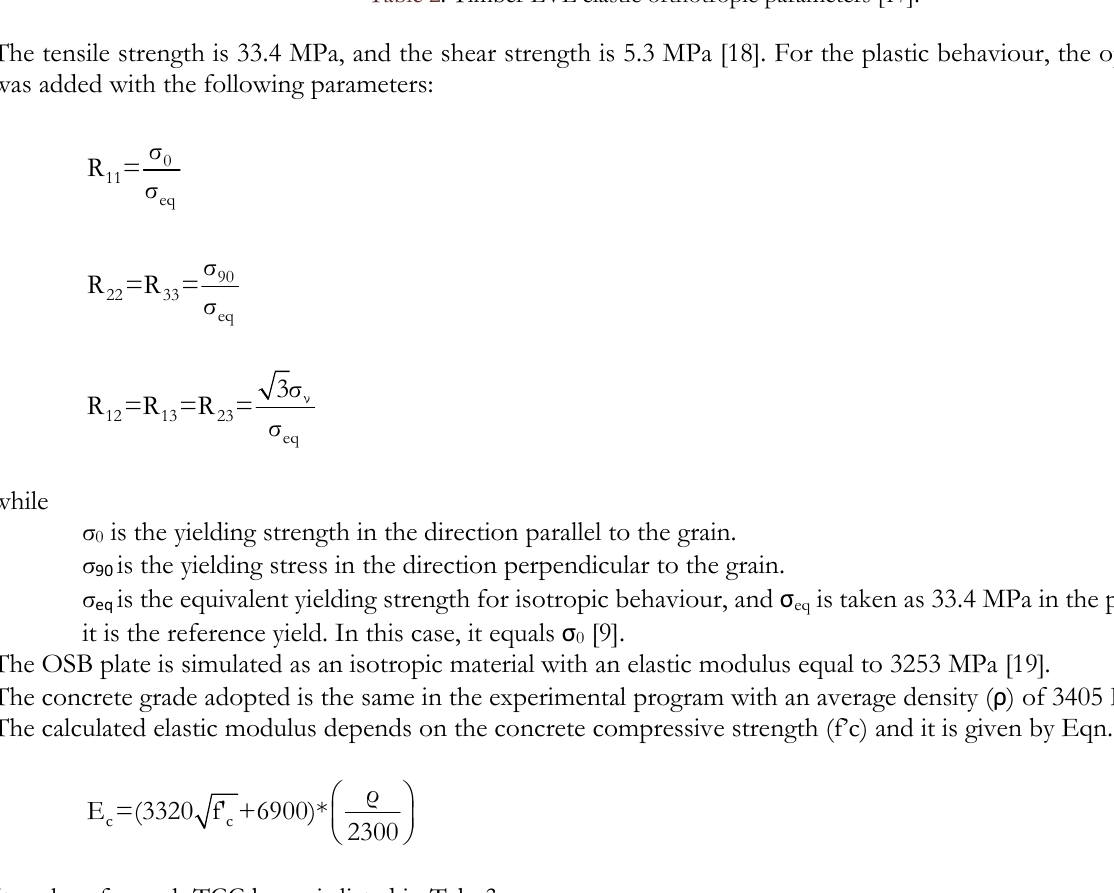
Table 2: Timber LVL elastic orthotropic parameters [17].